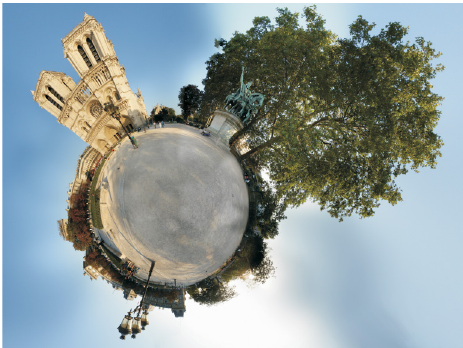
Fig. 18. Spherical Panorama “Globe Panorama”